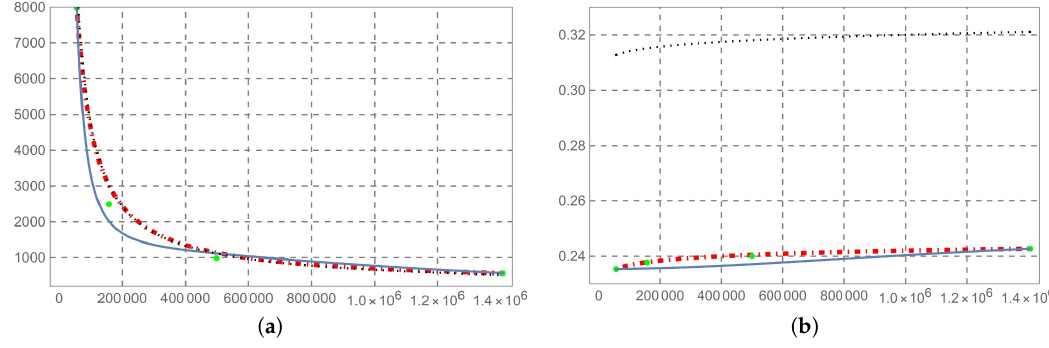
Figure 4. ( a ) Permittivity and ( b ) conductivity at frequencies 9 KHz @ 224 KHz. Line dot-dashed fractional model α = 0.990, line continue ordinary model, line dotted extensive Cole–Cole’s model, points experimental data.